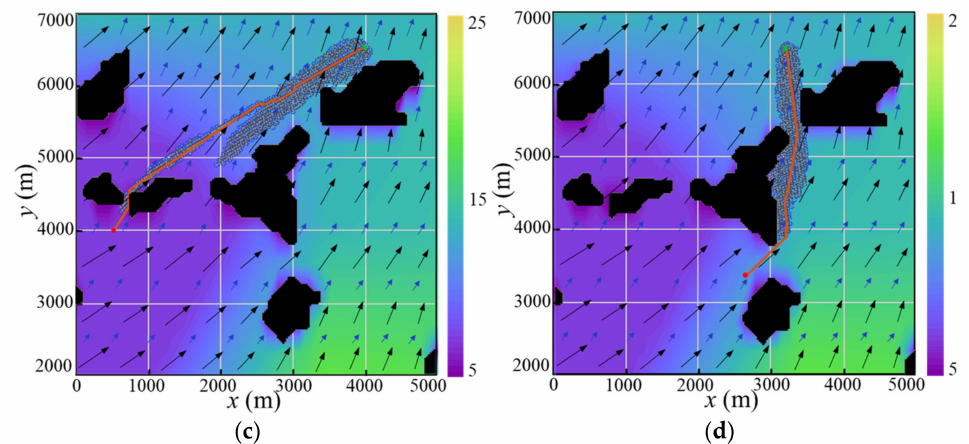
Figure 11. Comparison of motion planning paths at different starting and goal